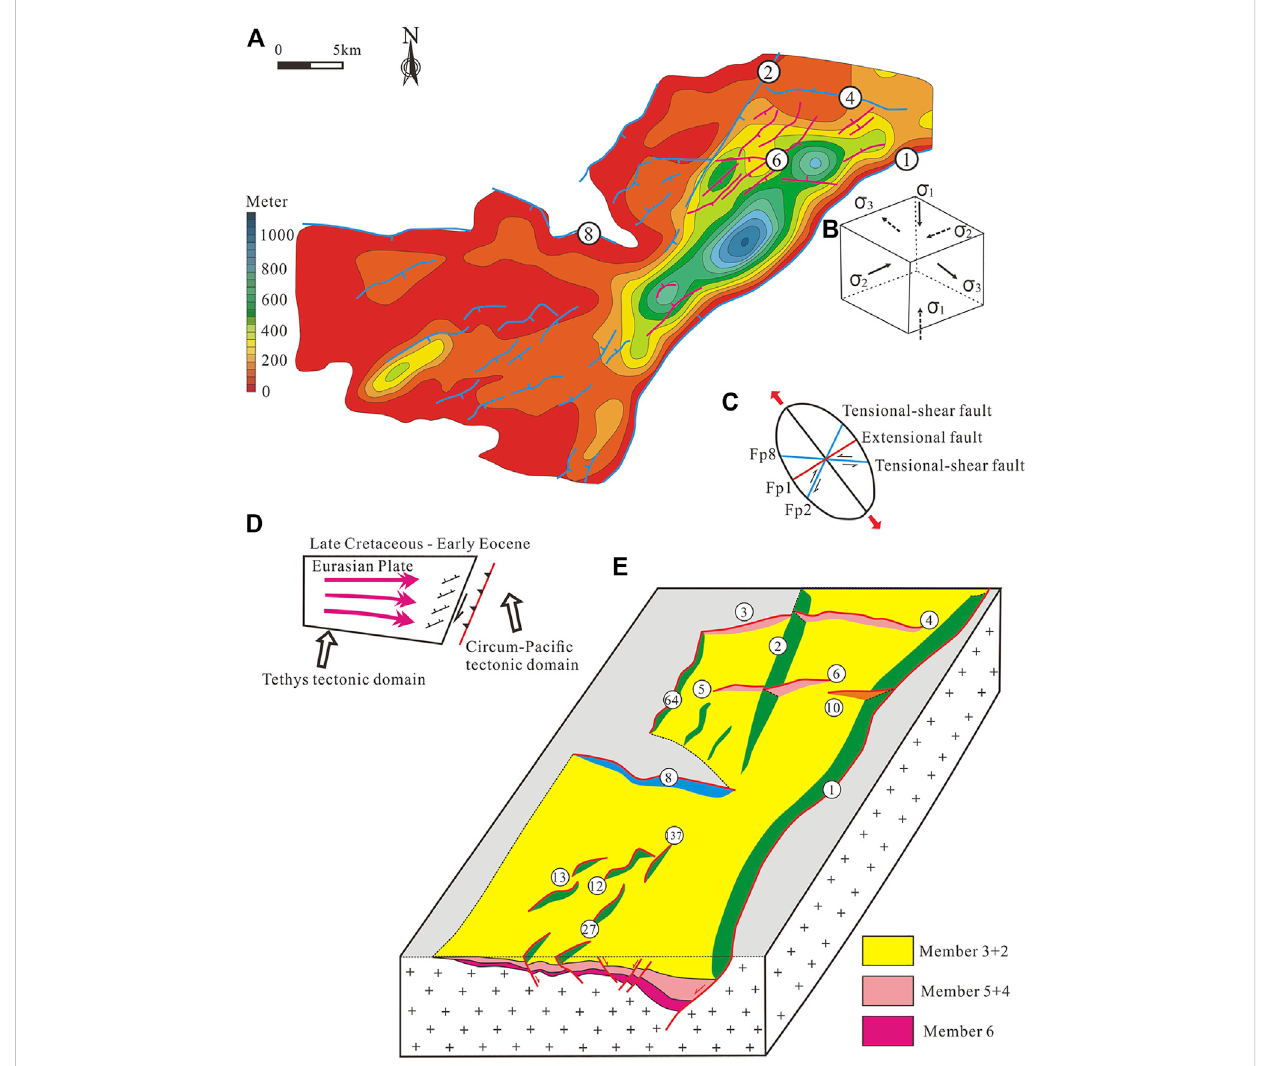
FIGURE 13 (A) The prototype basin of Member 5 in Wenchang Formation; (B) Three-dimensional stress state of principal stress in the middle Eocene of Paleogene; (C) Strain ellipse under the direction of NW-SN; (D) Movement status of Eurasian Plate, Tethys tectonic domain and Circum-Paci fi c tectonic domain; (E) Formation model